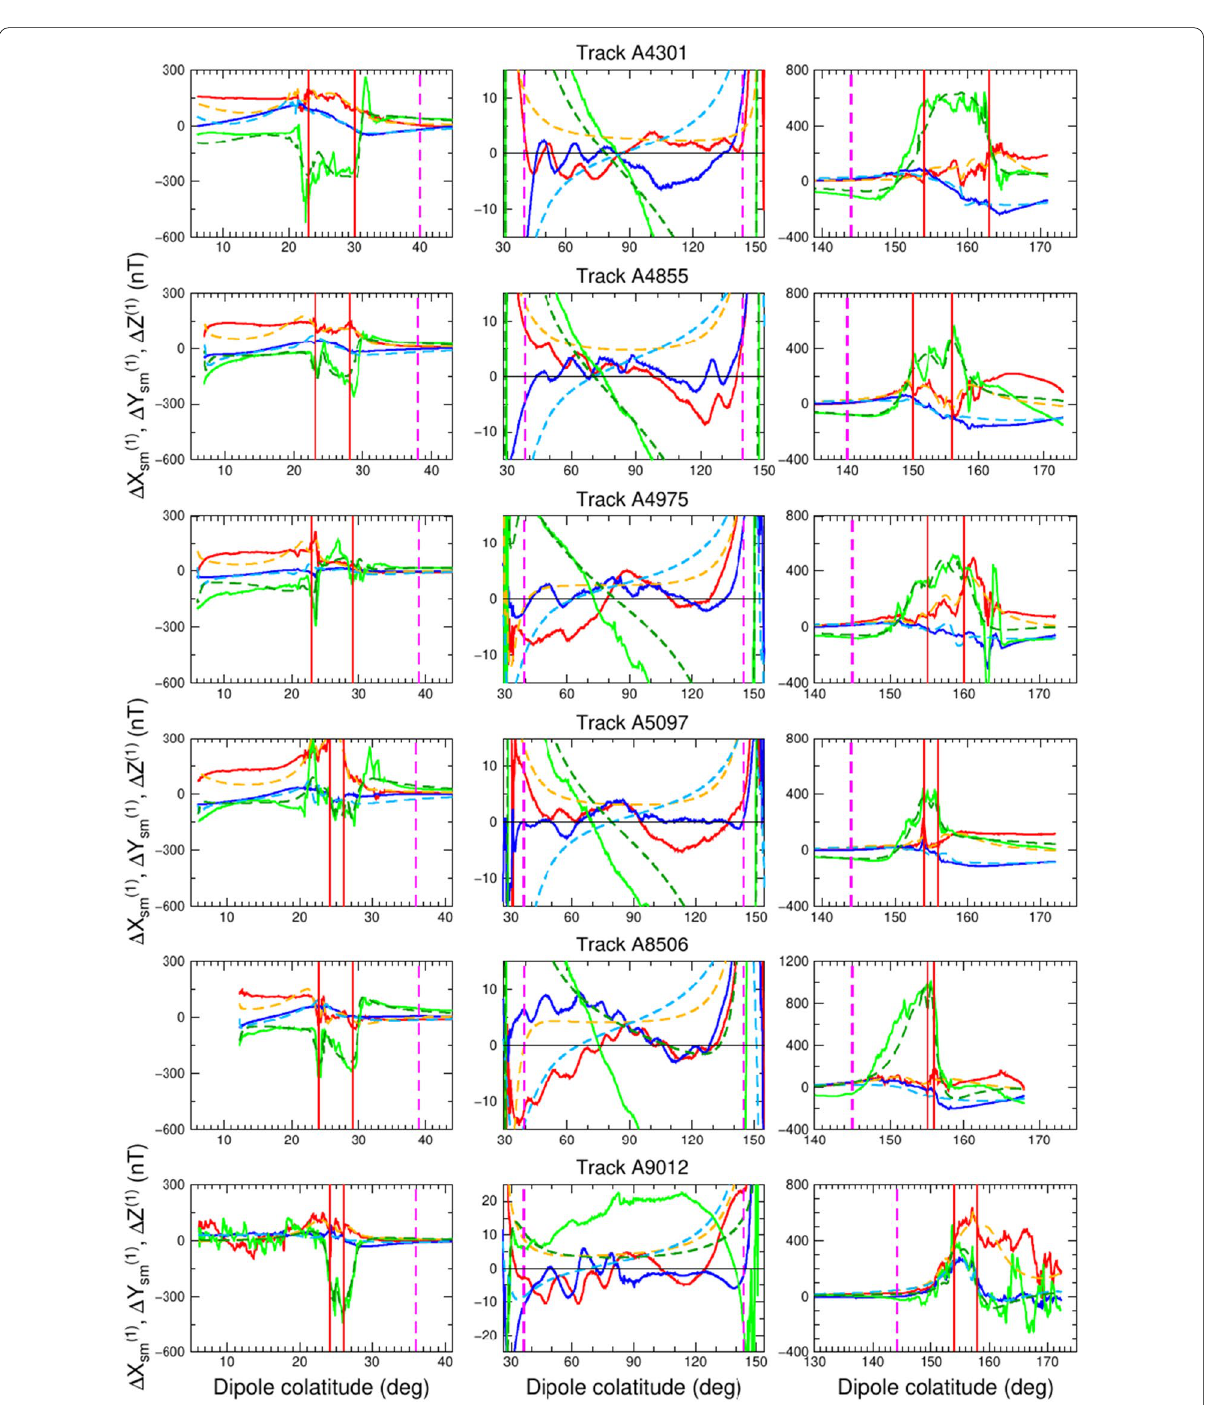
Fig. 10 The Swarm residuals � X ( 1 ) sm (solid red), � Y ( 1 ) sm (solid green) and � Z ( 1 ) (solid blue) along six Swarm A nightside full tracks (see Table 1) and their best fits by the regularised linear least squares (dashed lines) for α 2 = 2 × 10 − 10 nT 2 A − 2 . The left, middle and right columns stand for the northern polar region, mid-latitudes and southern polar region, respectively. The vertical red lines in the left-hand and right-hand panels denote the estimated positions of the northern and southern auroral ovals, respectively; see Fig. 8. The mid-latitudes ranges between colatitudes ϑ sm,R n − 10 ◦ (vertical dashed violet and ϑ sm,R s 2